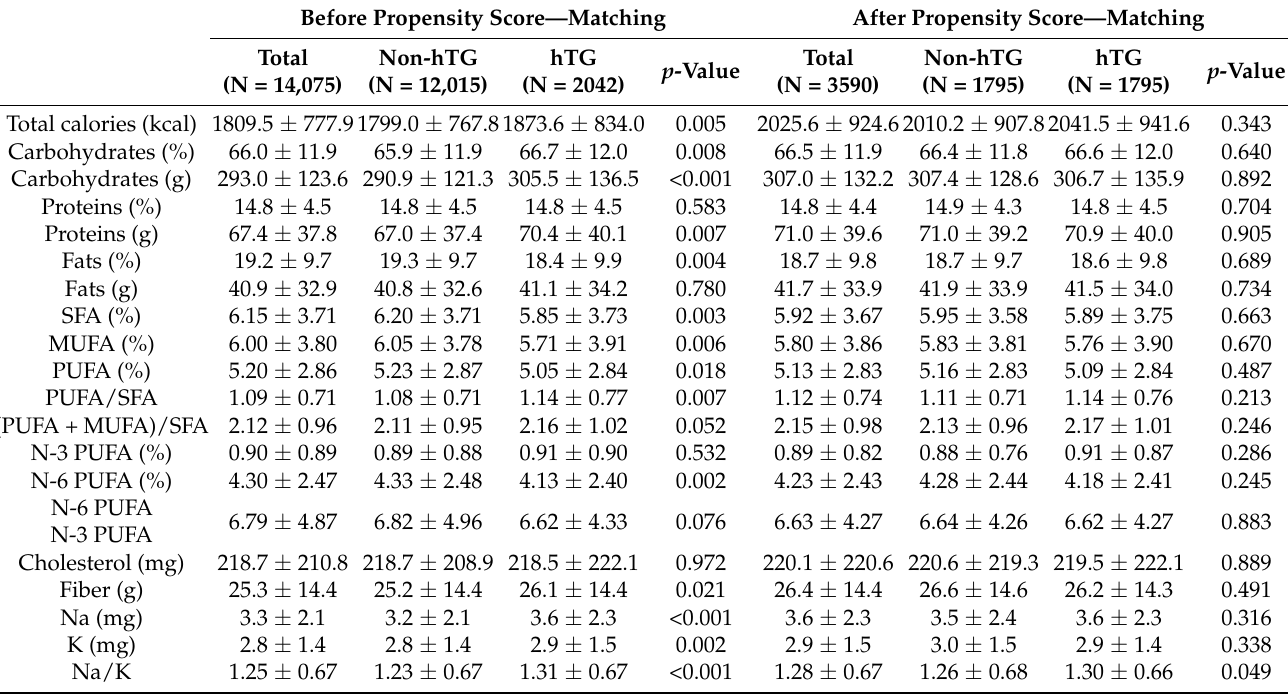
Table 4. Daily nutrient intake of study population according to the presence of hypertriglyceridemia. Before Propensity